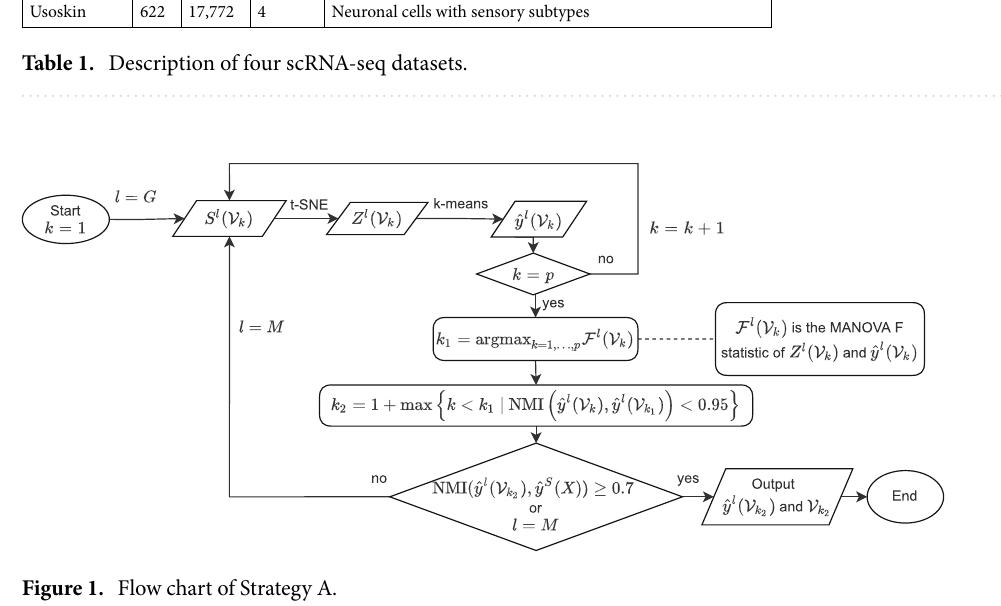
Figure 1. Flow chart of Strategy